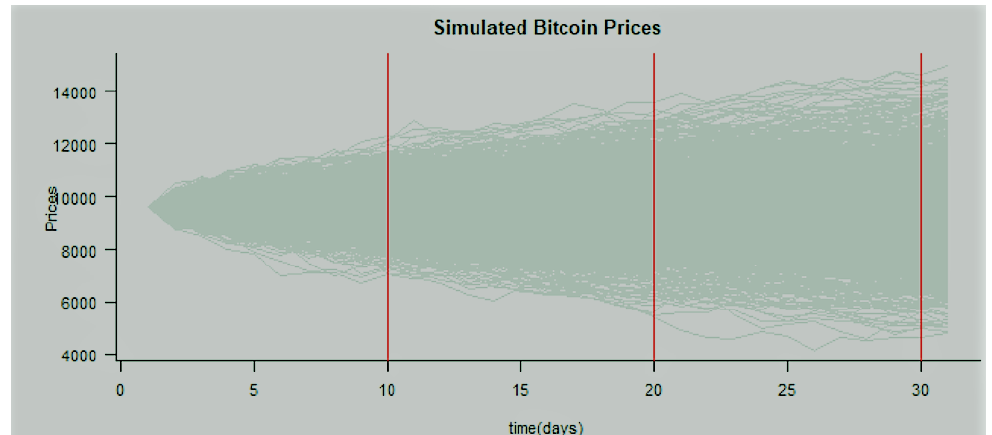
Figure 4. Trajectories of simulated Bitcoin